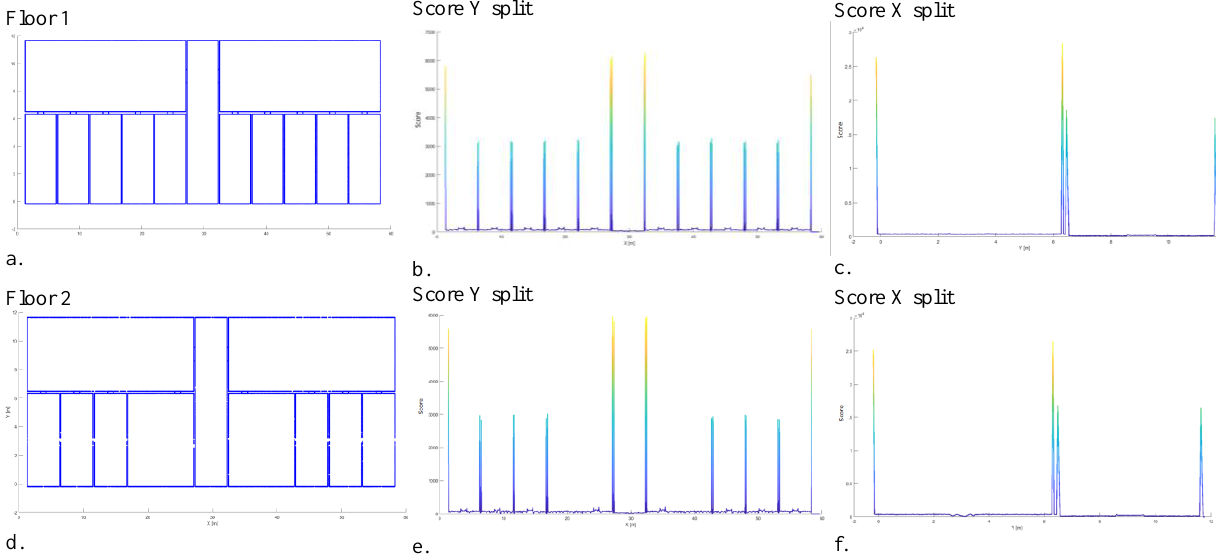
Figure 3. Building floorplan for Floor 1 (a) and Floor 2 (d) with score function C hor and C ver for Floor 1 (b and c respectively) and for Floor 2 (e and f respectively).